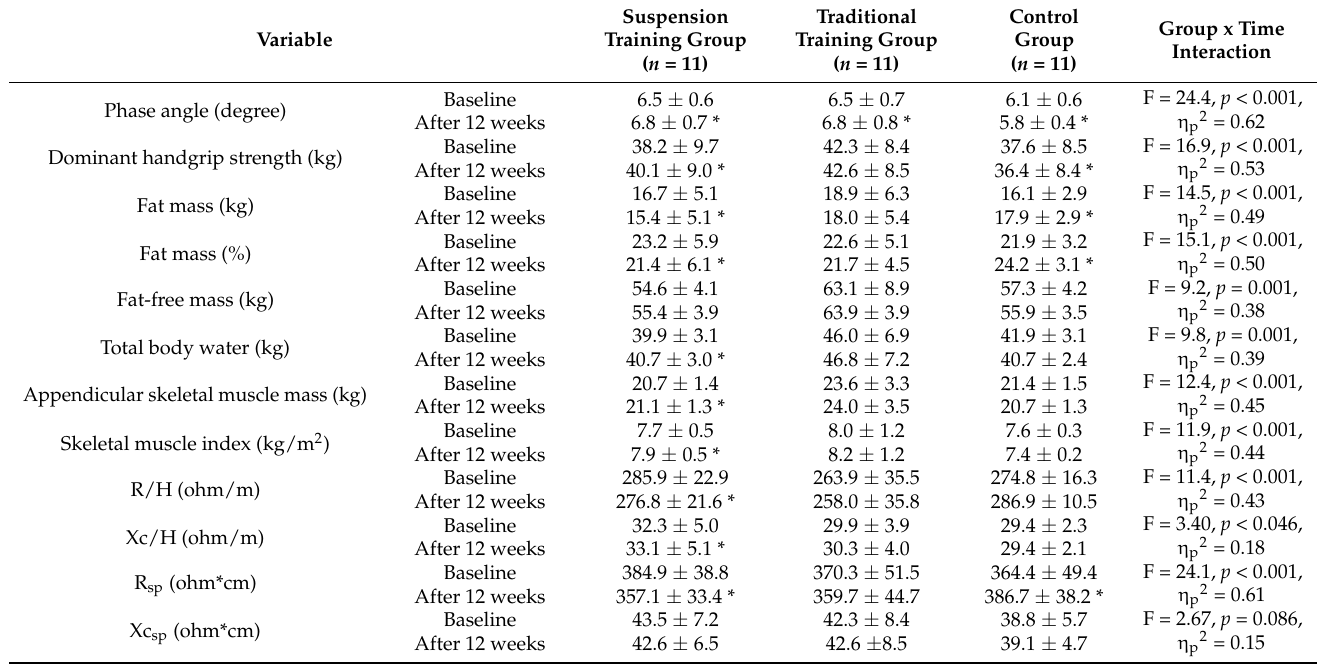
Table 1. The baseline (mean ± standard deviation) and post 12 weeks values (mean ± standard deviation) of the dependent parameters are shown.